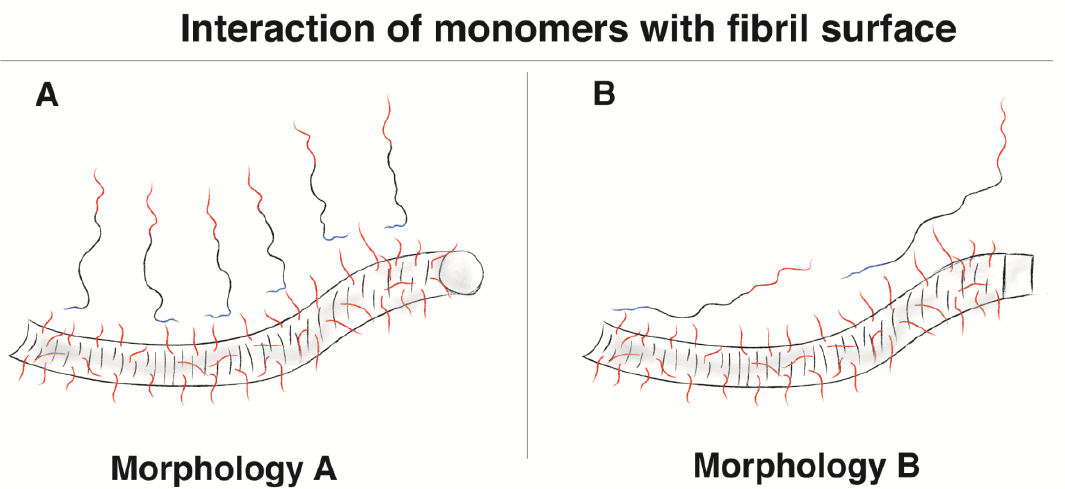
Figure 8. Simplified illustration comparing the interactions of monomers with the surface of mor- phologies A and B. ( A ) Monomers interacting with the surface of morphology A, showing how mainly the first residues of the N-terminus interact with the fibril surface. ( B ) Monomers interacting with the surface of morphology B, showing how a large part of the monomer is affected by the interaction between the monomers and the fibril surface, where the N-terminus and probably also the N-terminal part of the NAC region is the main binding site but that the rest of the molecule also interacts to some degree.